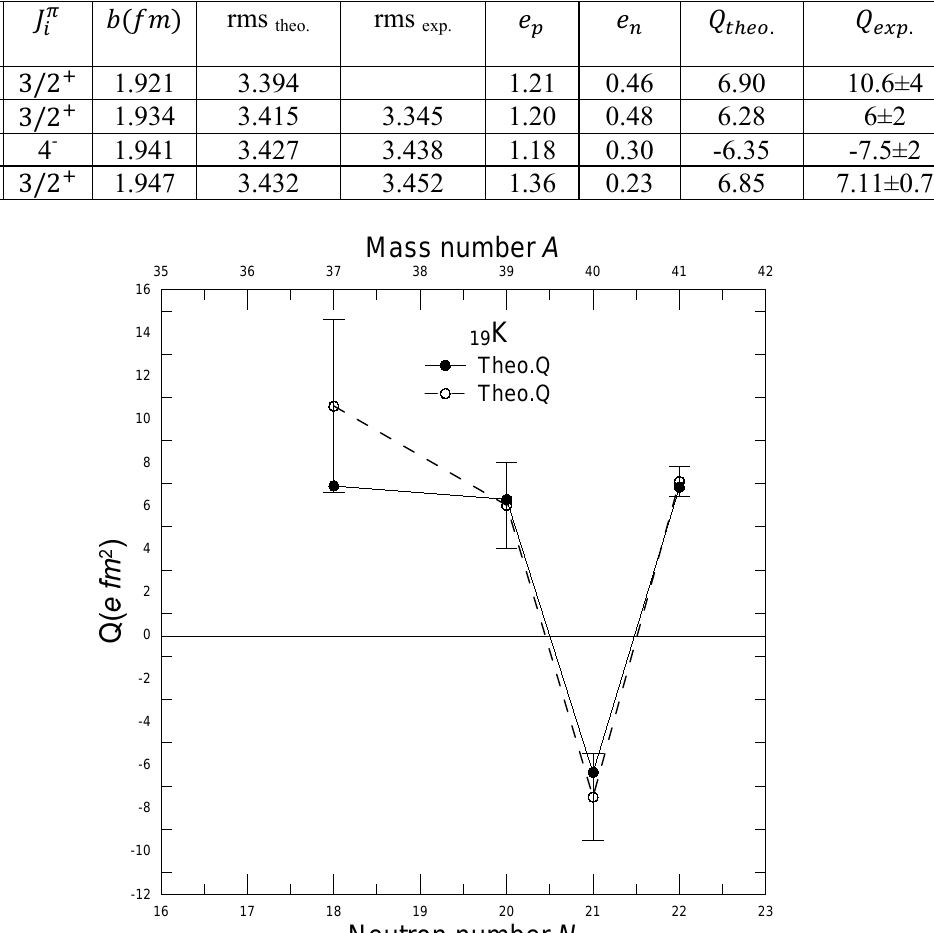
Fig. 7: Experimental [18] and theoretical quadrupole moments versus neutron number for K